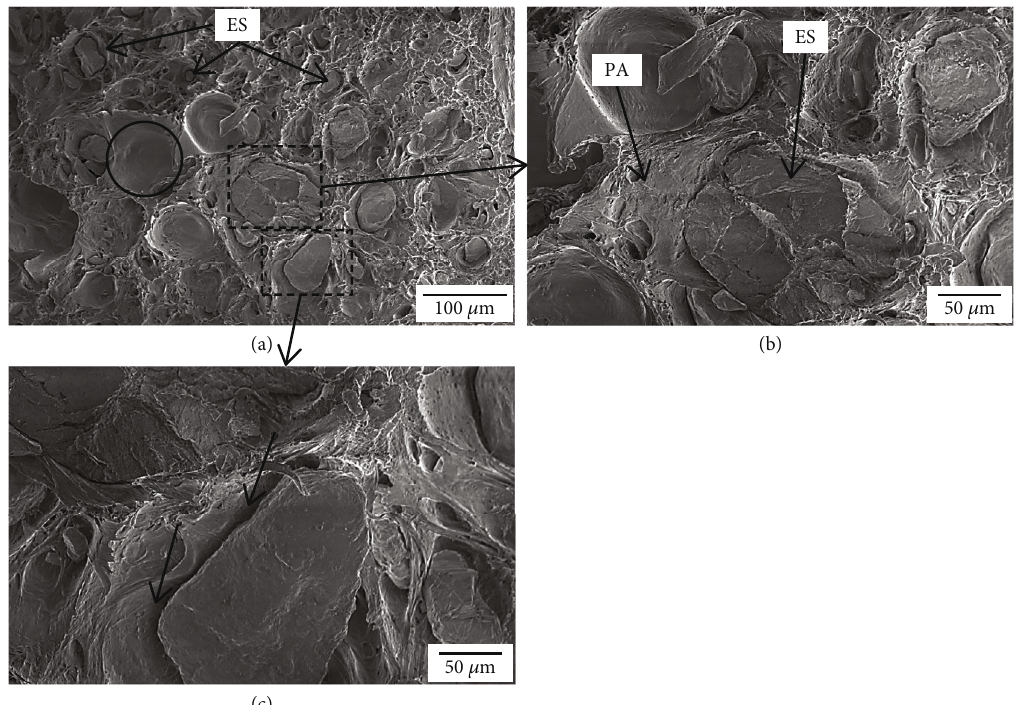
Figure 4: SEM images of the fractured surfaces of cured PA10 composites: (a) Overview of the fracture surface reveals the distribution of the ES particles in the PA matrix, (b) Reveals an embedded ES particle in the PA matrix, and (c) reveals de-bonded ES particle from the PA matrix. Circles in (a) show pull out particles (ES) from the matrix (PA). Arrows in (c) show a noticeable gap between the ES particle and PA